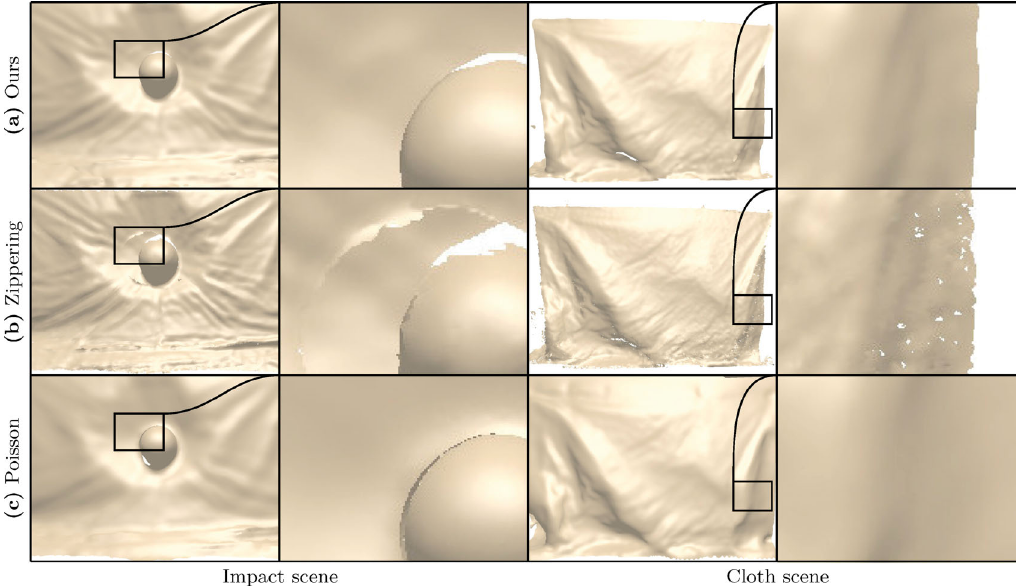
Fig. 12 Comparison of 3D reconstruction methods: (a) shows our method, (b) uses MLS-based mesh zippering [24], and (c) shows the Poisson reconstruction method [19]. Zippering shows bad edge quality and occasionally has incorrect triangles protruding from surfaces. The Poisson method tends to over-smooth areas and incorrectly handles open